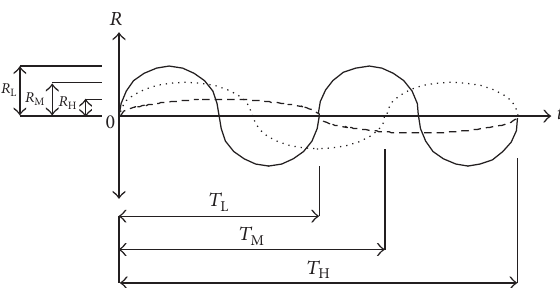
Figure 8: Structural dynamic response, 𝑅 , versus dominant vibra- tion period: 𝑇 , 𝑇 , and 𝑇 : dominant vibration periods for high, H M L medium, and low structural ductility,